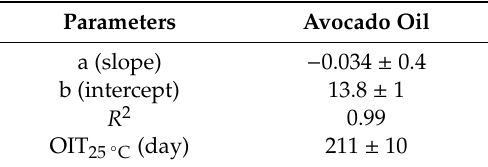
Table 3. Calculated results of the linear relationship between the natural logarithm of the OIT assessed by the Rancimat test and the temperature for the treatment combinations in.